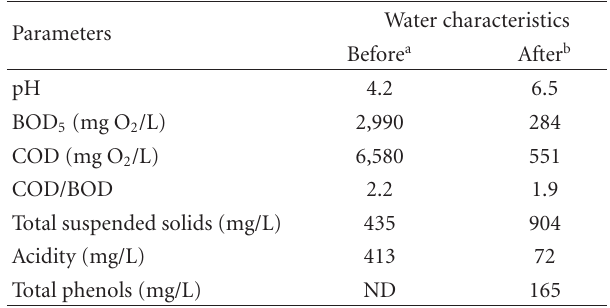
Table 4: Physicochemical parameters of co ff ee wet processing wastewater before and after biological treatment in SMTA.